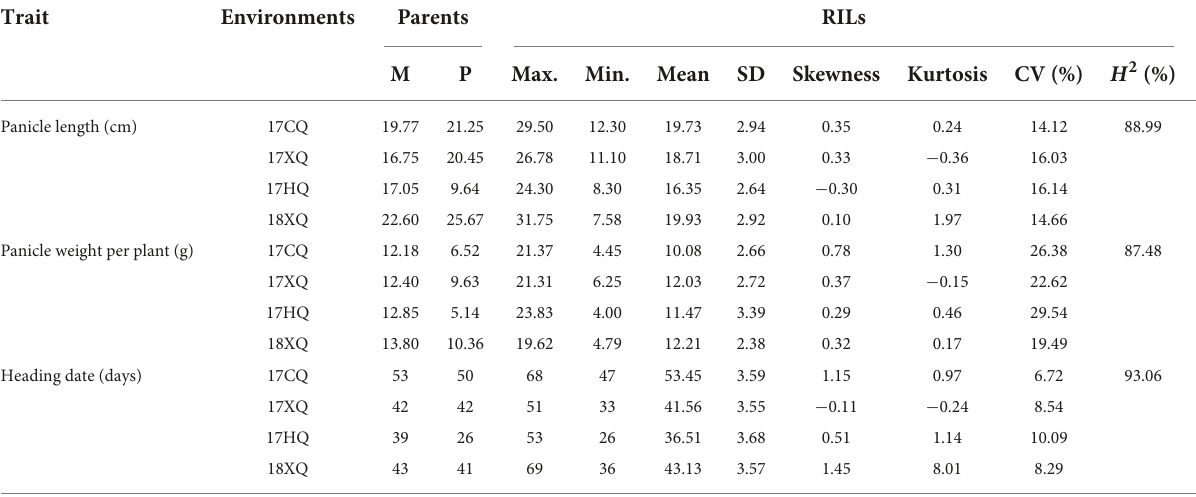
TABLE 1 Summary of phenotype data for quantitative traits of the foxtail millet recombinant inbred line (RIL) population in four environments. Trait Environments Parents RILs